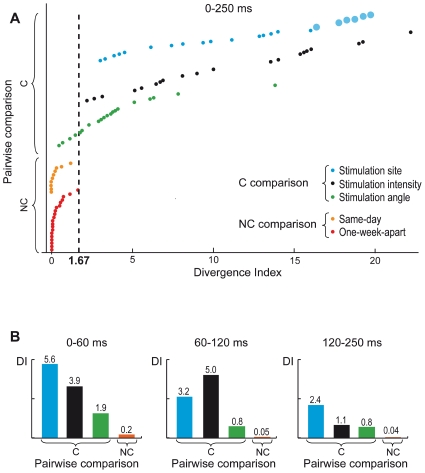
Divergence Index of all pairwise comparisons between TMS-evoked potentials.Single DI values computed over the entire post-stimulus period (250 ms) are shown in (A) with the following color-coding: DIs of the C comparisons for changes in the stimulation site, intensity and angle are represented by cyan, black and green dots, respectively, while DIs of NC comparisons are depicted in yellow for same-day sessions and in red for one-week-apart sessions. DI values computed over different temporal windows of interest (0–60 ms, 60–120 ms, 120–250 ms) are reported in (B) with the same color-coding, except for NC comparisons that are summed together and plotted in orange.